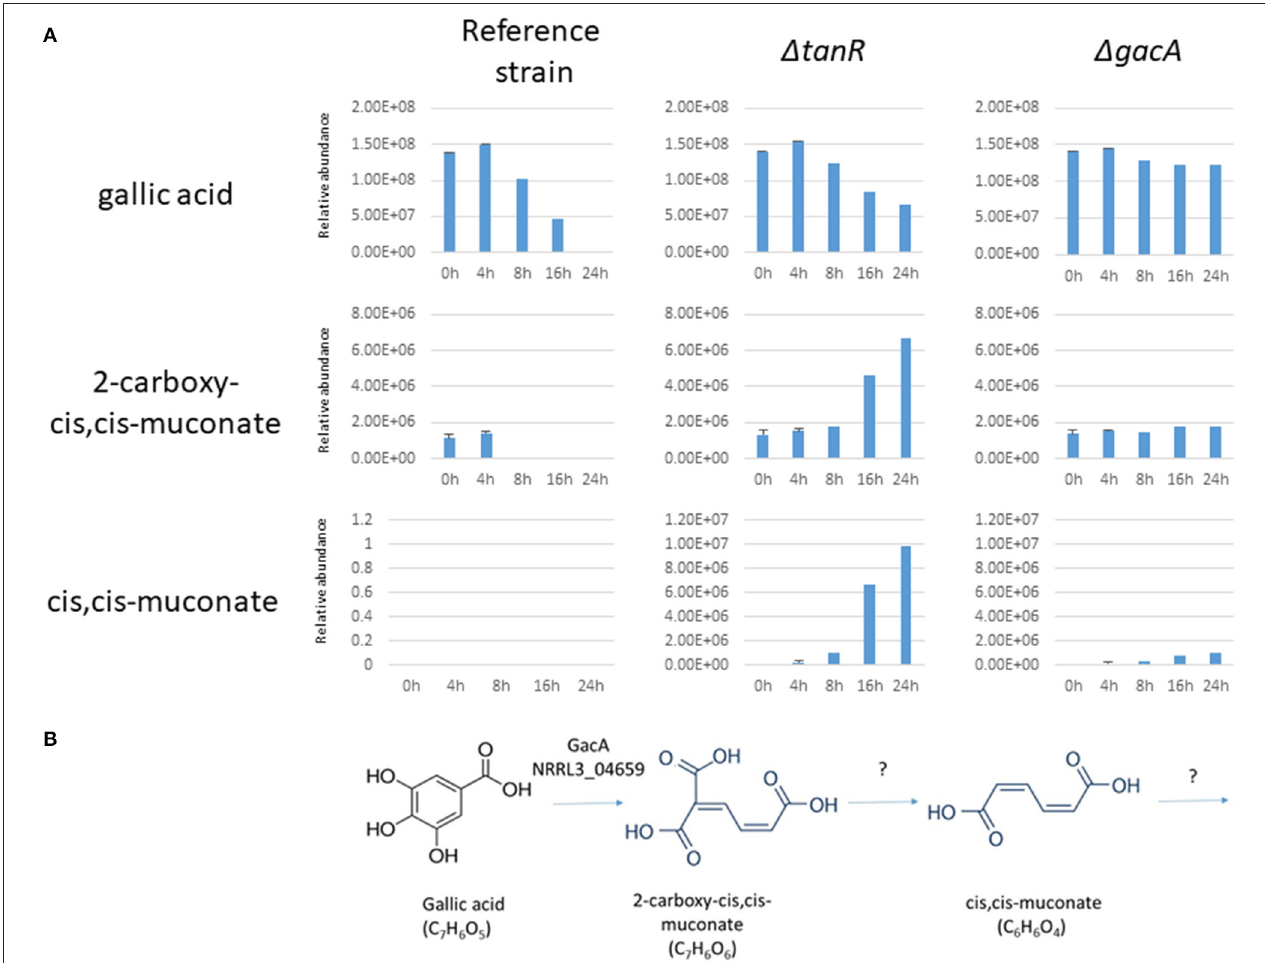
FIGURE 5 | (A) Extracellular metabolites analysis of A. niger strains grown after transfer to 1% gallic acid/0.1% fructose. A. niger strains MA234.1 (reference strain), the 1 tanR mutant, and the 1 gacA (NRRL3_04659) mutant were pregrown in CM supplemented with fructose for 24h, mycelium was washed and transferred MM supplemented with 1% gallic acid/0.1% fructose for the indicated times. Most abundant extracellular metabolites (gallic acid, 2-carboxy-cis,cis-muconate and cis,cis-muconate) were detected and their relative abundance over time course (0, 4, 8, 16, and 24h after transfer) were analyzed as described in Materials